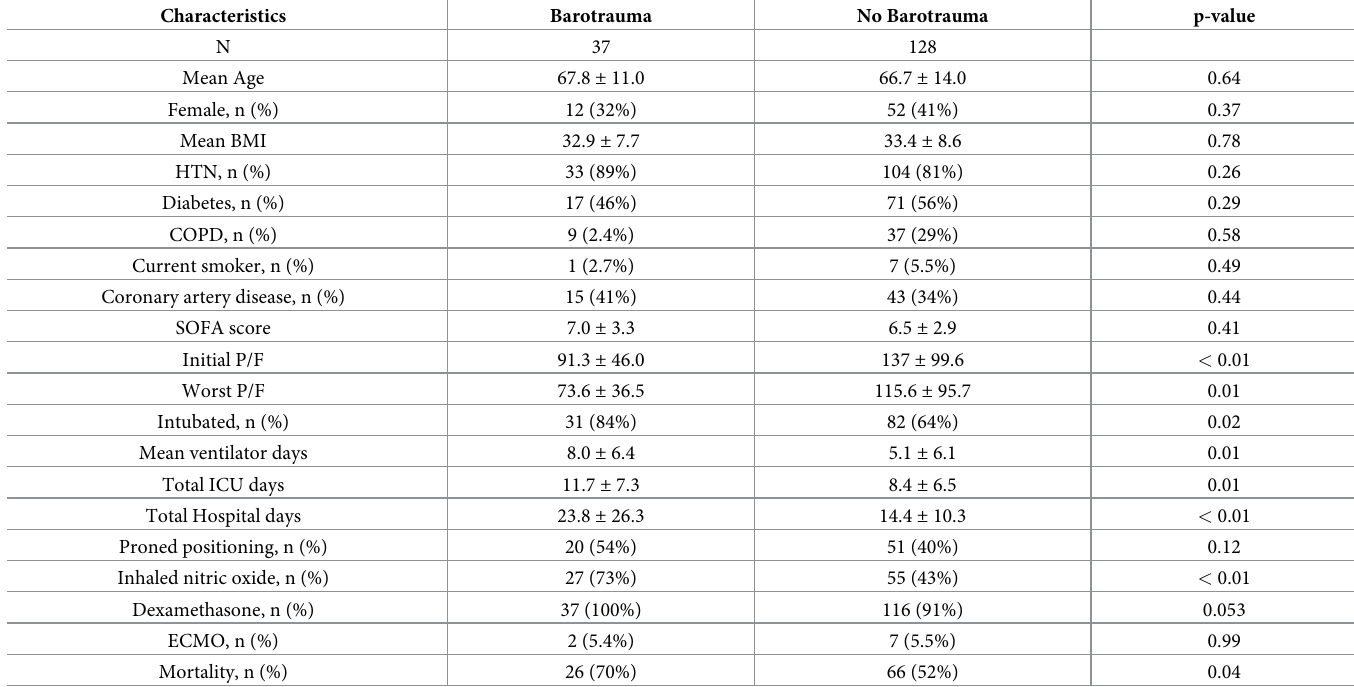
p = 0.043) as compared to COVID-19 without barotrauma. We compared barotrauma and COVID-19 patients with others using a multivariable logis- tic regression model adjusting for potential confounding variables including COPD and cur- rent smoking status. The odds ratio for 30-day mortality in COVID-19 with barotrauma from the fitted model was 2.39 (p = 0.025). Table 3. Characteristics and outcomes of patients with COVID-19 admitted to the ICU who had barotrauma compared to no barotrauma.